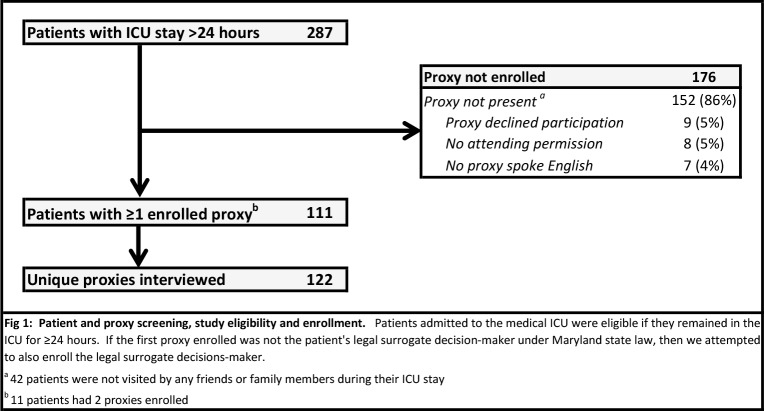
Patient and proxy screening, study eligibility and enrollment.Patients admitted to the medical ICU were eligible if they remained in the ICU for ≥24 hours. If the first proxy enrolled was not the patient's legal surrogate decision-maker under Maryland state law, then we attempted to also enroll the legal surrogate decisions-maker. a 42 patients were not visited by any friends or family members during their ICU stay b 11 patients had 2 proxies enrolled.